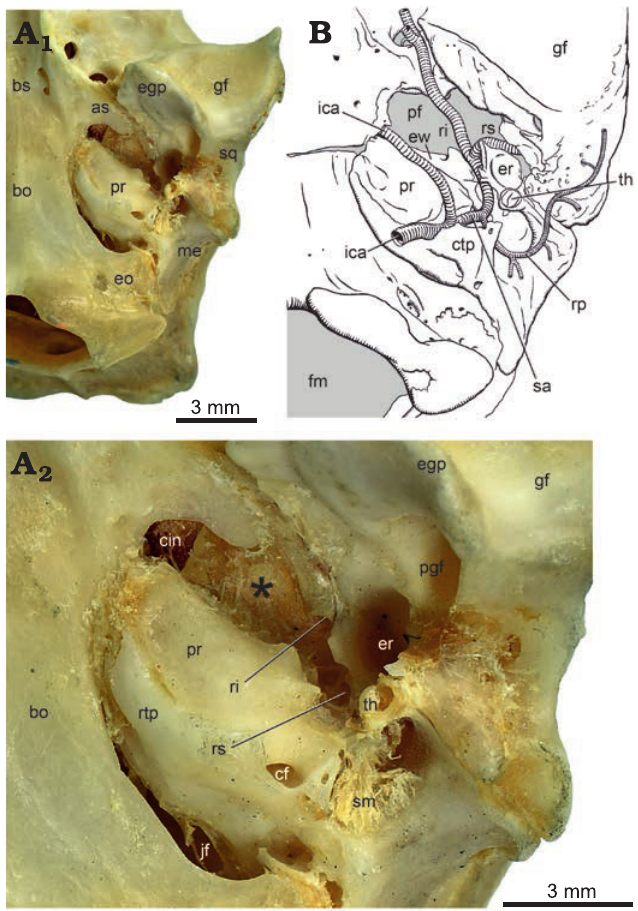
Fig. 7. Lipotyphlan mammal Solenodon paradoxus Brandt, 1833, left basi- cranium in ventral view. A . CM 18069, photograph of adult (A 1 ); close-up of ear region (A 2 ). B . Drawing of juvenile AMNH 28272 with arterial re- construction based on MPIH 6863 (modified from Wible 2008: fig. 26C). Caudal tympanic process of the petrosal is broken in CM 18069, exposing the cochlear fossula. Asterisk in A 2 is on the membrane of the piriform fenestra in the location of the tensor tympani muscle. Tympanohyal does not contact caudal tympanic process in juvenile AMNH 28272 but does in adults (Wible 2008). Abbreviations: as, alisphenoid; bo, basioccipital; bs, basisphenoid; cf, cochlear fossula; cin, carotid incisure; ctp, caudal tympanic process of petrosal; egp, entoglenoid process; eo, exoccipital; er, epitympanic recess; ew, epitympanic wing of petrosal; fm, foramen magnum; gf, glenoid fossa; ica, internal carotid artery; jf, jugular foramen; me, mastoid exposure; pf, piriform fenestra; pgf, postglenoid foramen; pr, promontorium of petrosal; ri, ramus inferior; rp, ramus posterior; rs, ramus superior; rtp, rostral tympanic process of petrosal; sa, stapedial artery; sm, stapedius muscle; sq, squamosal; th,